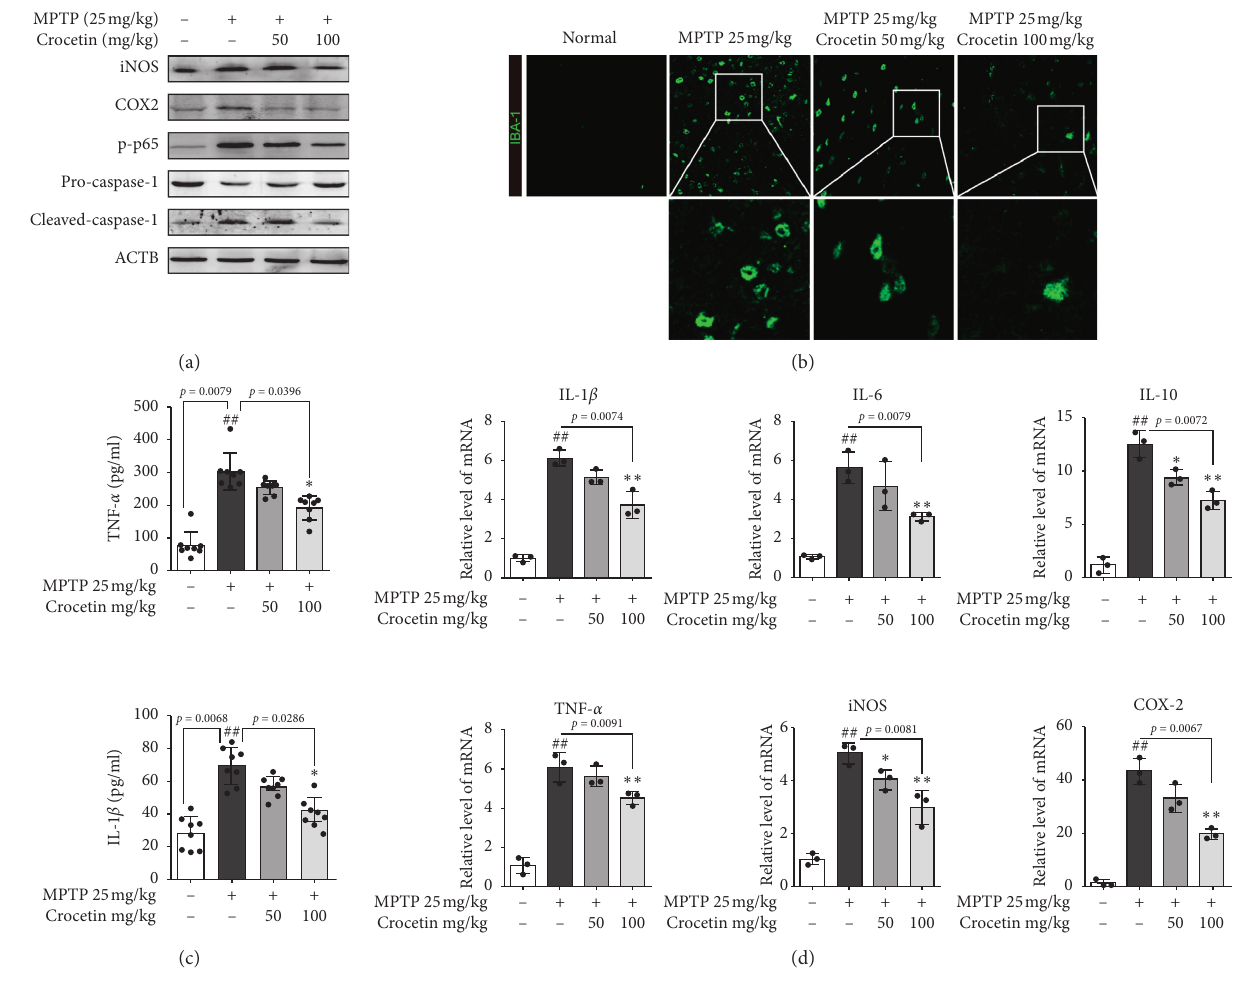
Figure 2: Crocetin inhibits inflammation in the MPTP-induced PD model. (a) The protein level of iNOS, COX2, p-p65, pro-caspase-1, and cleaved-caspase-1 in the striatum of crocetin-treated PD mice was measured using Western blot assay. (b) The expression of Iba-1 in the striatum was detected using the immunofluorescent assay. (c) The level of TNF- α and IL-1 β in the serum of crocetin-treated PD mice was detected by ELISA. (d) The mRNA level of IL-1 β , IL-6, IL-10, TNF- α , iNOS, and COX-2 in the striatum were measured using RT-qPCR. Data are expressed as the mean ± standard deviation, and statistical analysis was performed using a one-way analysis of variance followed by Tukey’s post hoc test. ## P < 0 . 01 versus control; ∗ P < 0 . 05, ∗∗ P < 0 . 01 versus